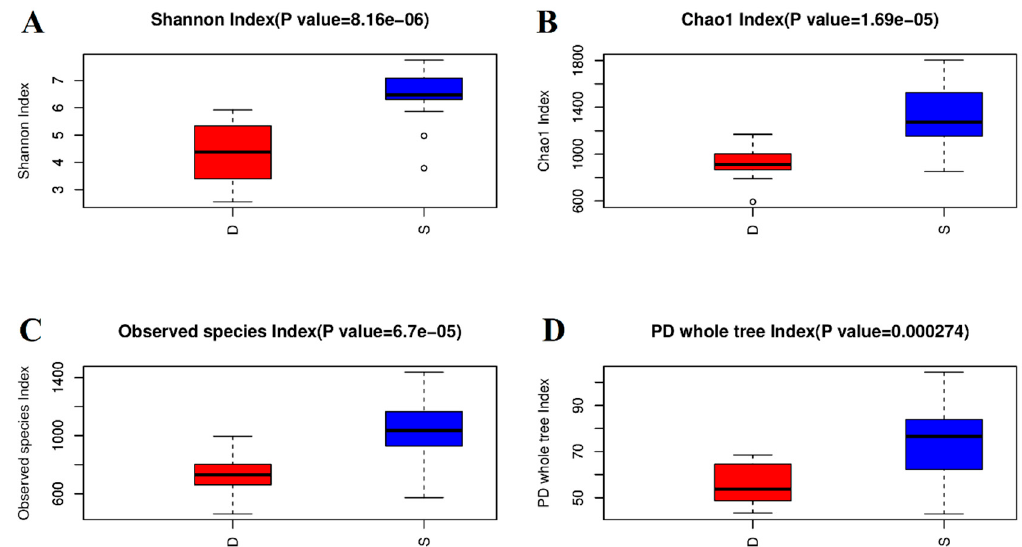
Figure 1. Alpha diversity of bacterial communities in two coastal areas S and D ( A – D ). Column height and error bar represent the mean value and standard deviation, respectively. PD, phyloge- netic diversity.